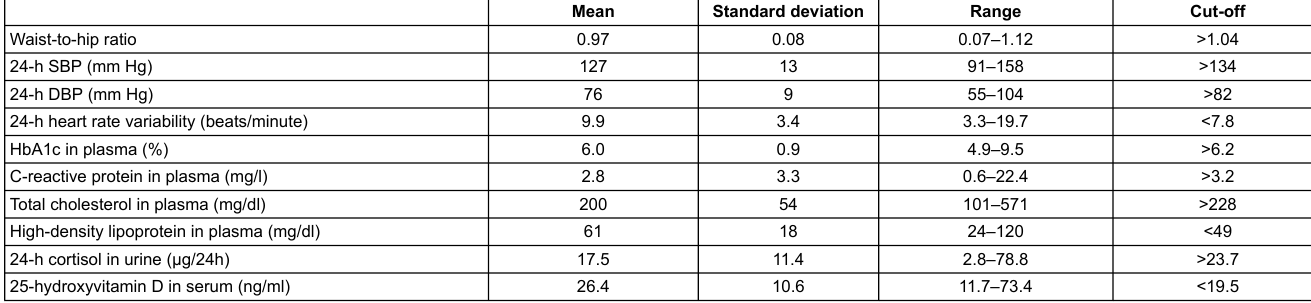
Table 1: Parameters used for calculation of allostatic load.